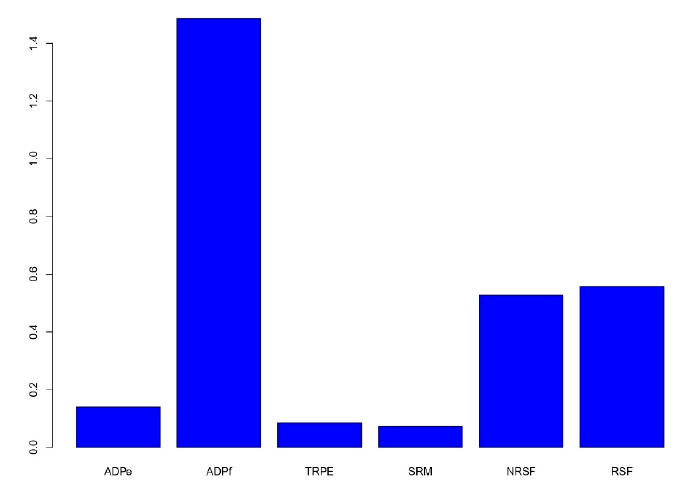
Figure 5. Size of the coefficients (AIC selected components—absolute values).